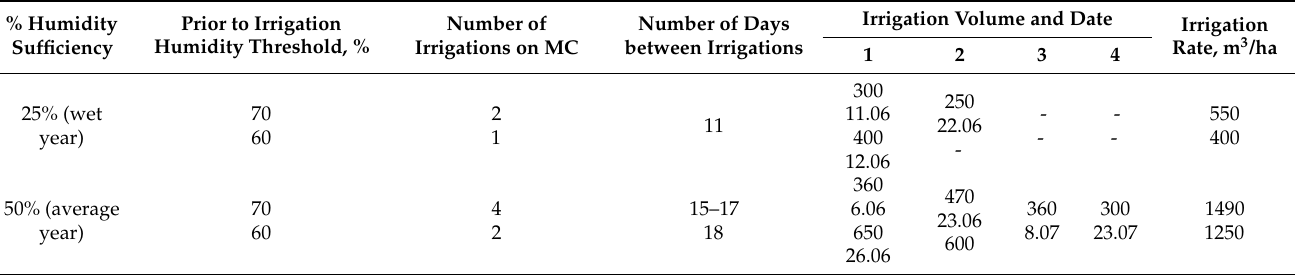
Table 3. Irrigation regime of spring wheat at the experimental